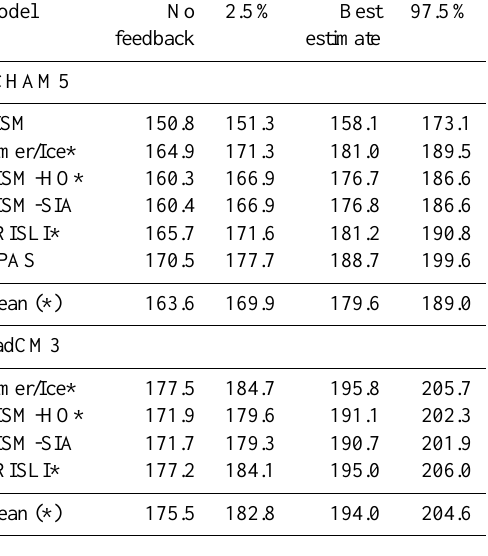
Table 4. Projected sea level contribution (mm) at 2100 for the ECHAM5 (top) and HadCM3 (bottom) A1B projections: no feed- back, 2.5% quantile, best, and 97.5% quantile estimates.